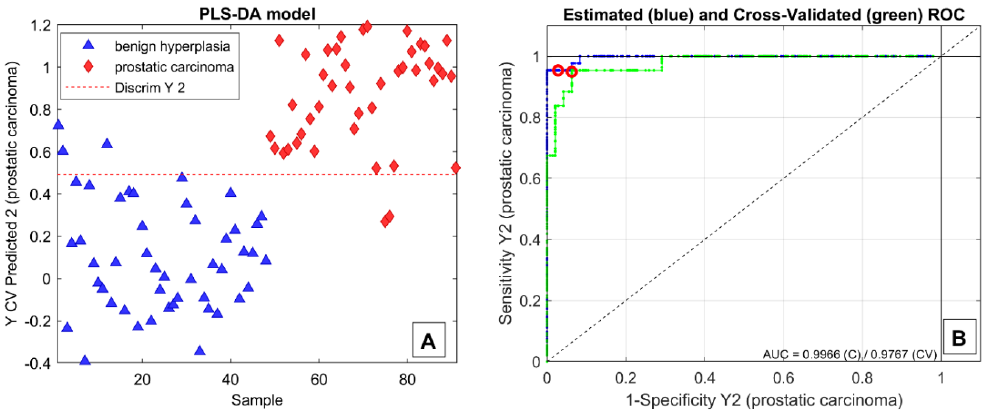
Figure 2. Y-value predicted in cross-validation (CV) ( A ) and receiver operating characteristic (ROC) curves ( B ) of one of the several classification models built during the repeated double cross-validation procedure.